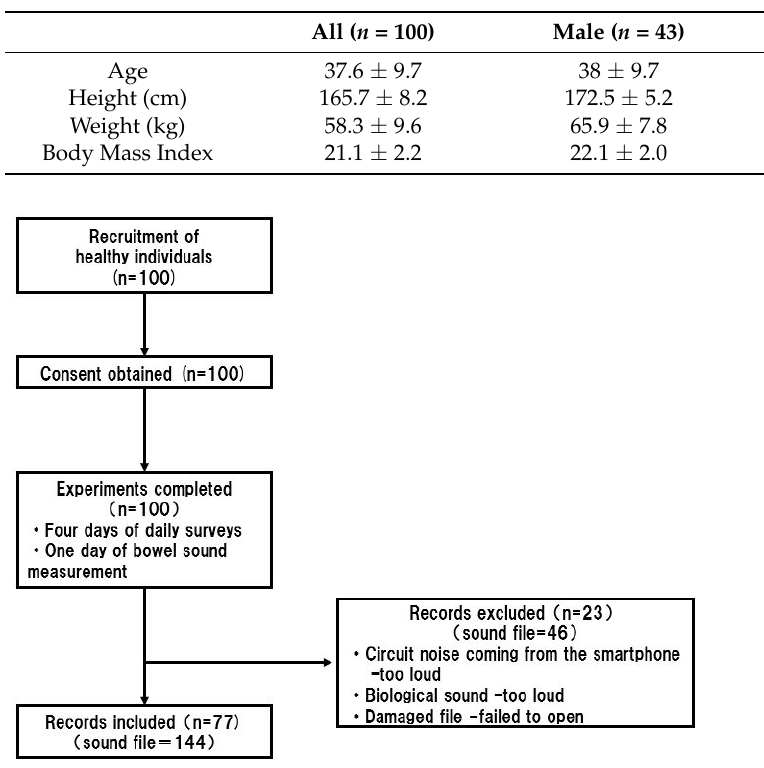
Figure 5. Flowchart of participant recruitment and data acquisition. All 100 participants completed the study. Due to noise contamination, the data for only 77 participants was used to build the machine learning model.